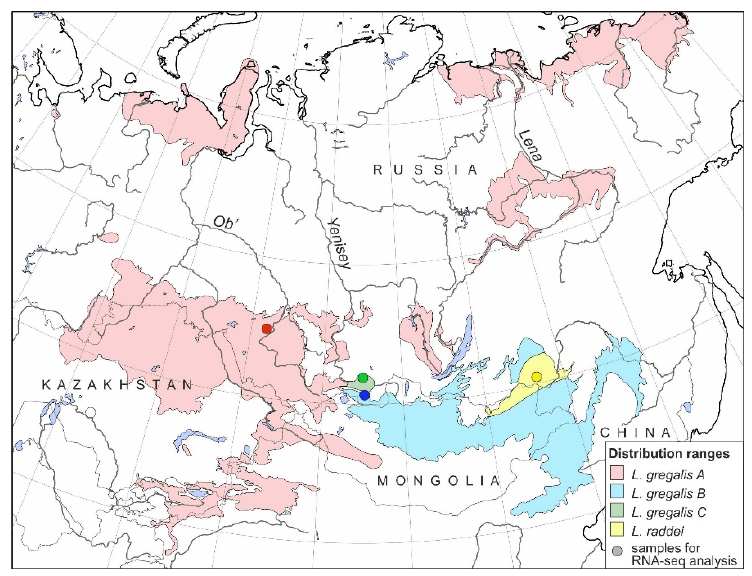
Figure 1. Distribution ranges of L. raddei and three lineages of L. gregalis (according to Batsaikhan et al. [31] with changes). Localities where animals for RNA-seq were sampled are marked with colored circles.